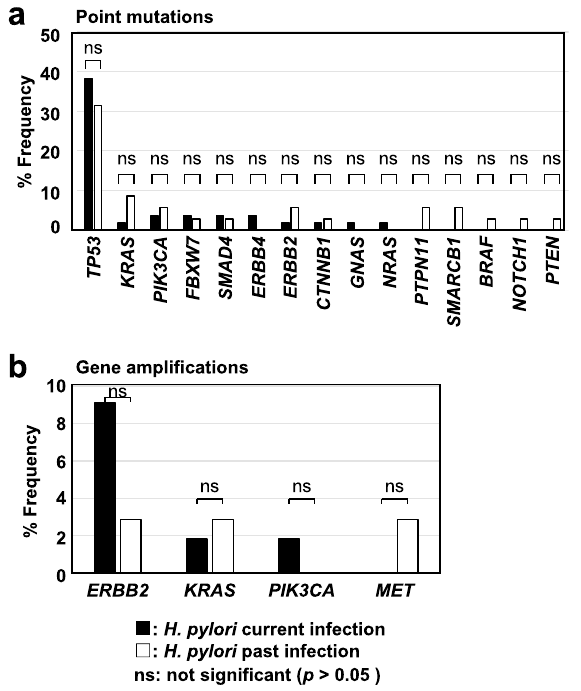
Figure 3. Frequency of point mutations and gene amplification in gastric cancers with current and past H. pylori infection. ( a ) Frequency of point mutations. Mutation frequencies of TP53 , KRAS , and PIK3CA were similar between gastric cancers with current H. pylori infection ( TP53 , 38%; KRAS , 2%; and PIK3CA , 4%) and those with past infection ( TP53 , 31%; KRAS , 9%; and PIK3CA , 6%). Black and white bars show frequencies in gastric cancers with current and past H. pylori infection, respectively. ( b ) Frequency of gene amplification of ERBB2 , KRAS , PIK3CA , and MET . The frequency was similar between gastric cancers with current H. pylori infection ( ERBB2 , 9%; and KRAS , 2%) and those with past infection ( ERBB2 , 3%; and KRAS , 3%). Black and white bars show frequencies in gastric cancers with current and past H. pylori infection,